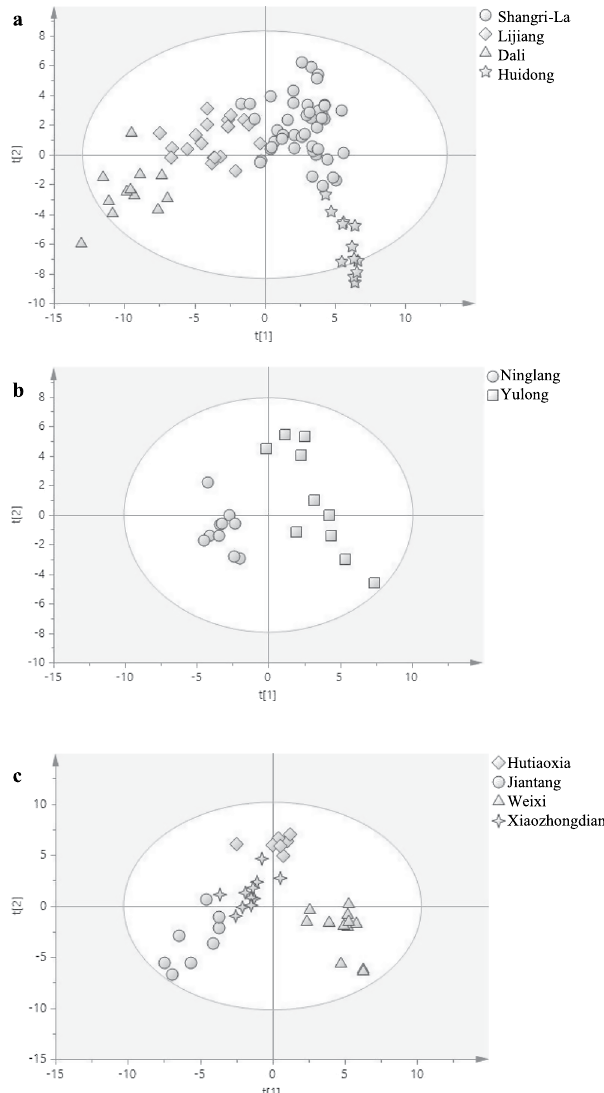
Figure 5. PLS-DA analysis of the Maca samples collected from different cities ( a ) and towns Ninglang and Yulong of Lijiang ( b ) and Weixi, Hutiaoxia, Jiantang and Xiaozhongdian of Shangri-La ( c